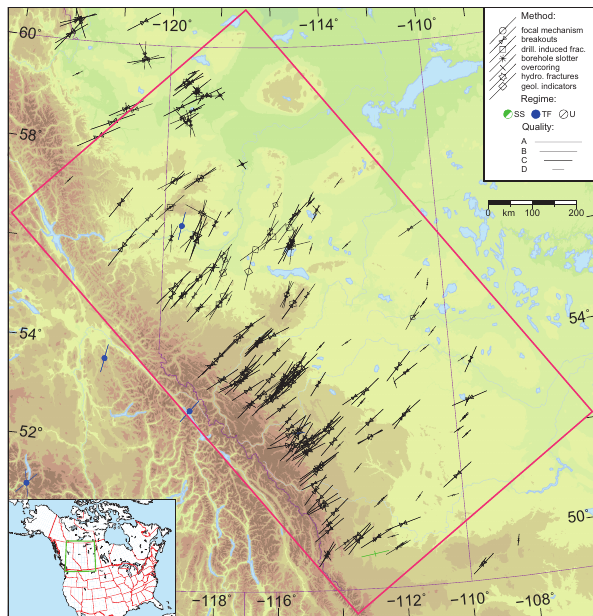
Figure 11. Crustal stress map of Alberta. Lines represent orien- tations of maximum horizontal compressional stress S Hmax ; line length is proportional to the data quality. Colours indicate stress regimes, with green for strike-slip faulting (SS), blue for thrust faulting (TF), and black for unknown regime (U). In summary, there are 321 S Hmax azimuth data available within the modelled region. Data are from the latest update of the Canadian stress map (Reiter et al.,